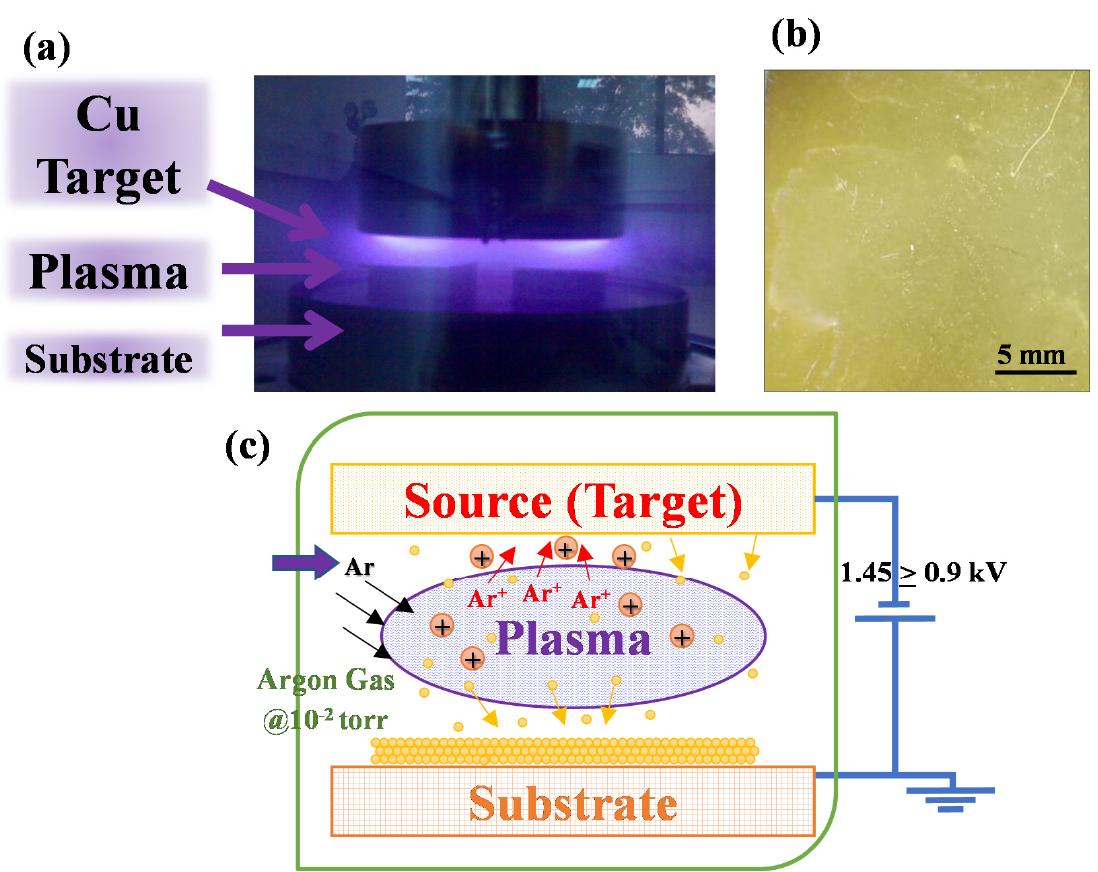
Figure 1. ( a ) Plasma assisted coating in the sputtering chamber, ( b ) Stereoscopic optical image of Cu coated sample, ( c ) Schematic representation of the sputtering phenomenon. Table 2. Percentage of light transmitted through thin films.